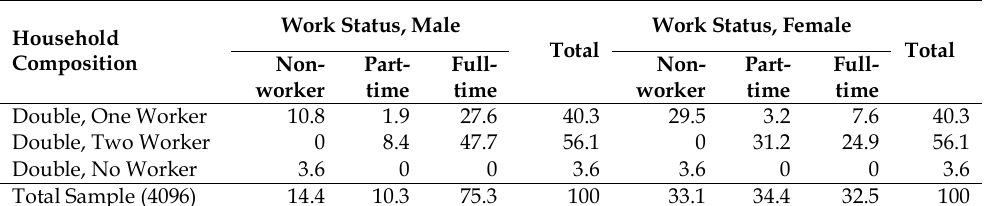
Table 3. Distribution of household heads across household composition and work status of household heads by gender (%)